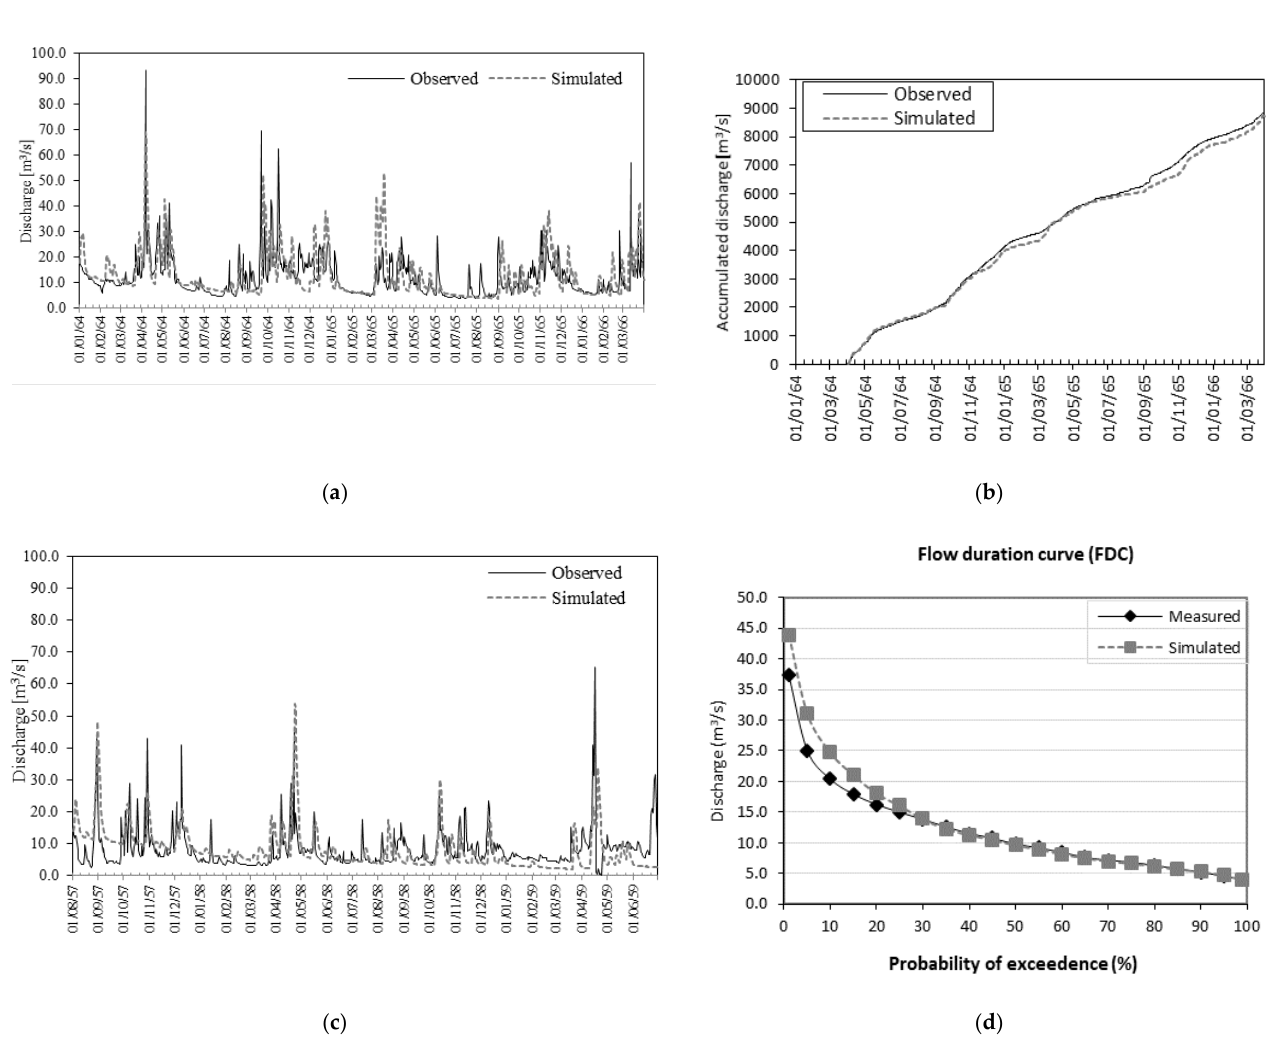
Figure 3 . Sebwe calibration plot ( a ), accumulated discharge plot ( b ), Validation plot ( c ) and Flow Duration Curve ( d ) .